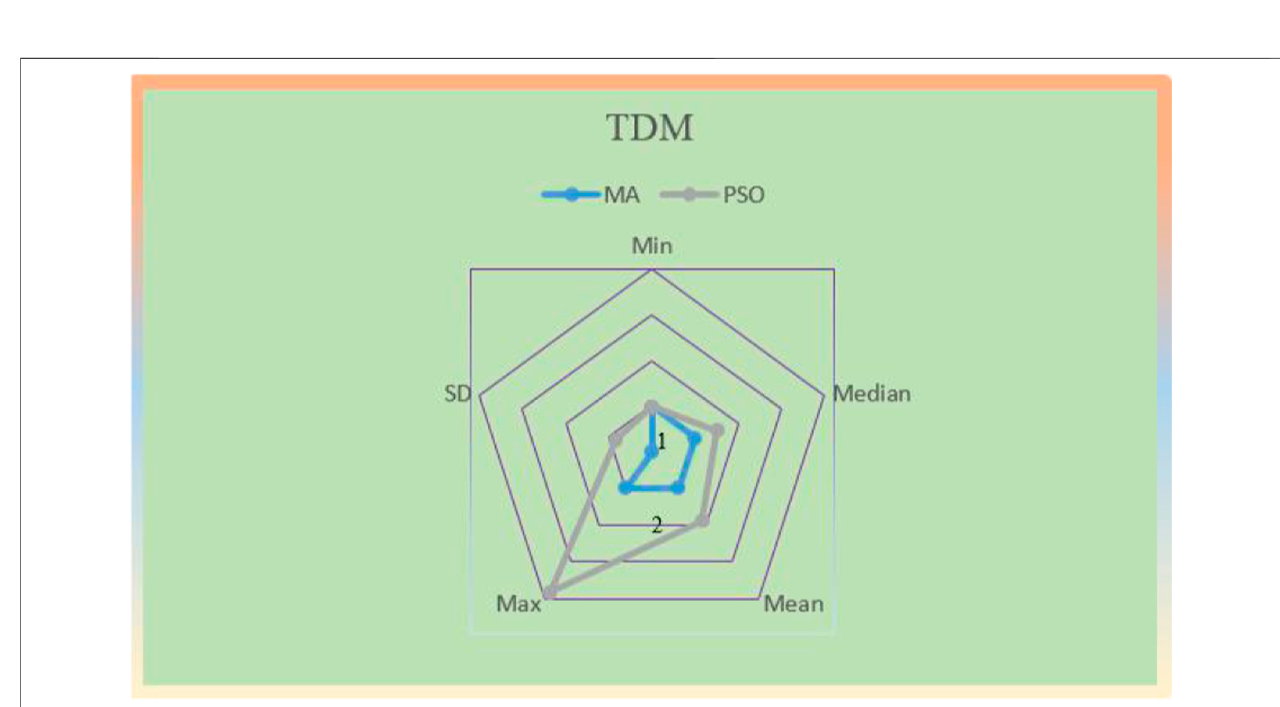
FIGURE 5 | Radar graph of two algorithms for the